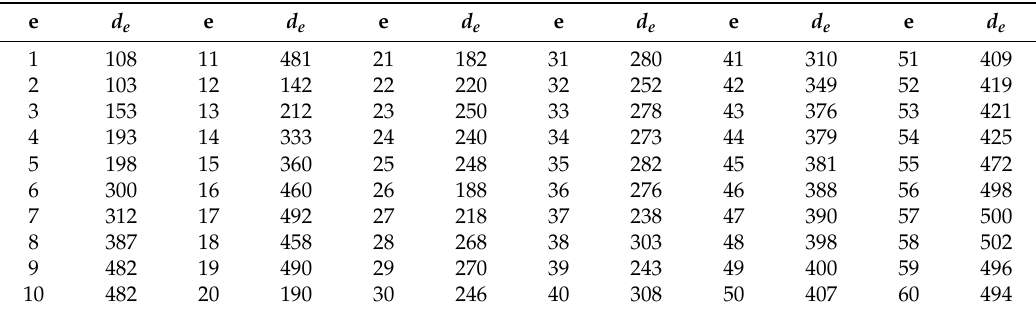
Table 5. Optimal